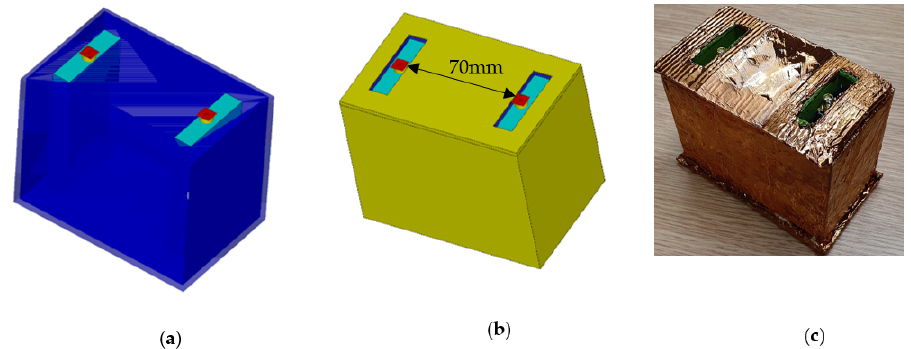
Figure 2. Oil spill sensing region at 70 mm antenna spacing: ( a ) acrylic, ( b ) Faraday cage in CST, ( c ) fabricated Faraday cage.